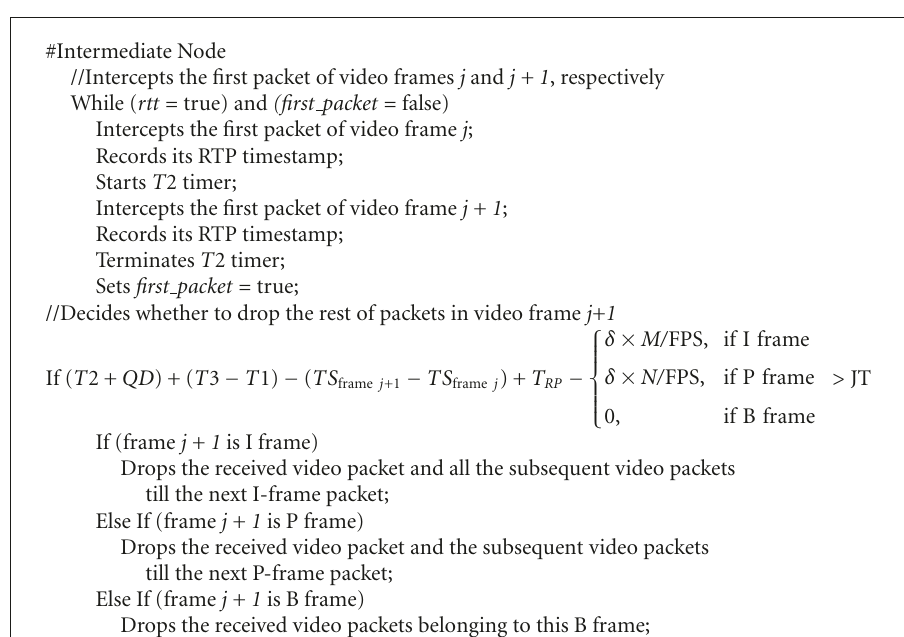
Algorithm 1: RTT measurement.